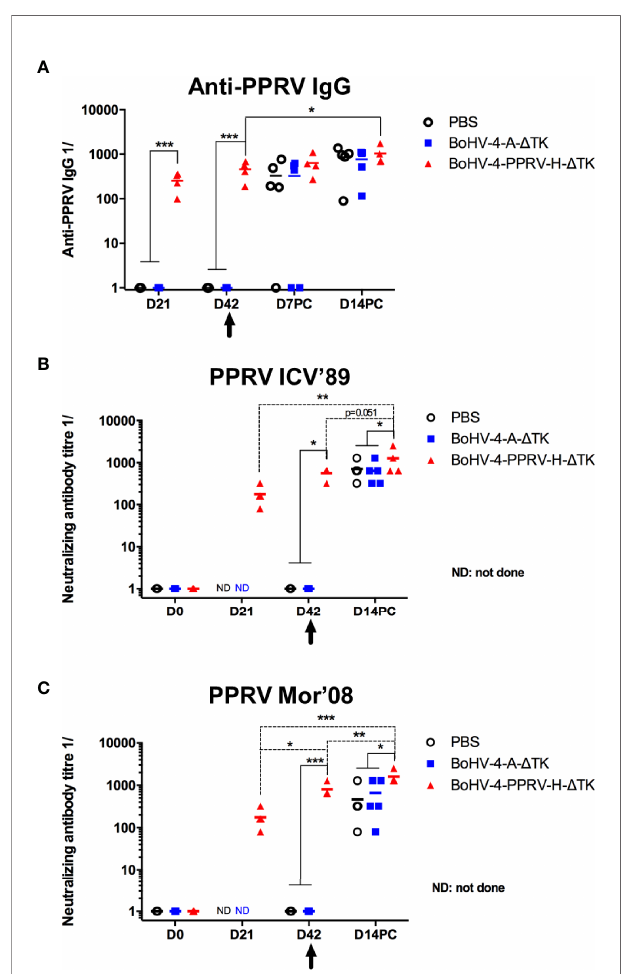
antibodies becoming detectable only at day 14 post-challenge.